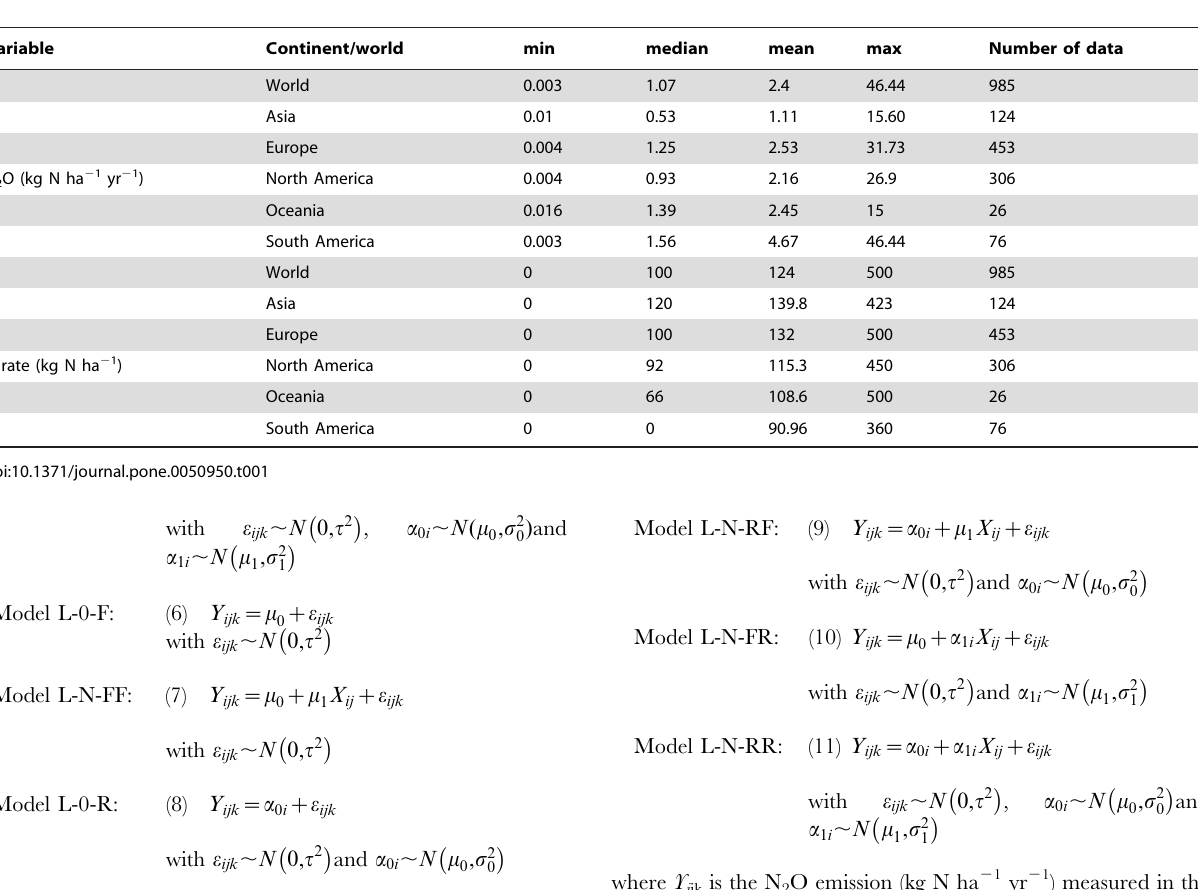
Table 1. Minimal, maximal, median and mean values of nitrous oxide (N 2 O) and amount of applied N (N rate) for the world and for North America, South America, Asia, Europe and Oceania.